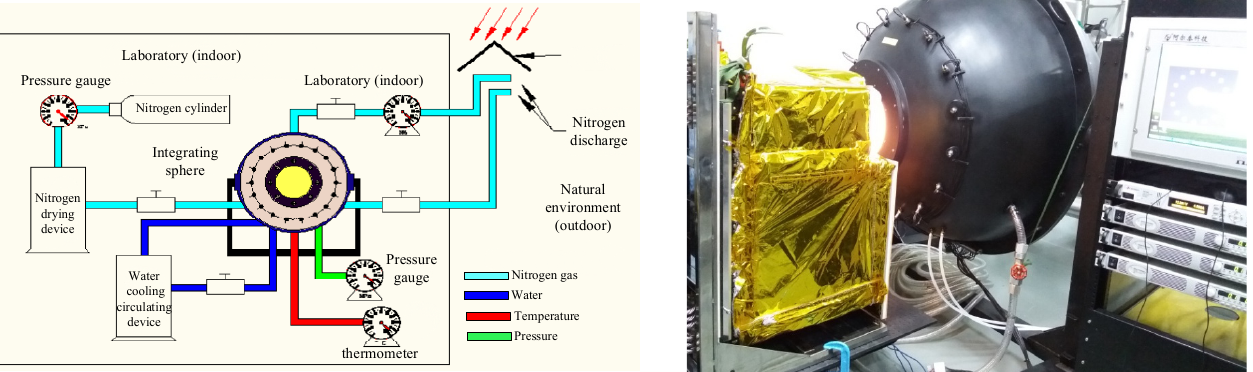
Figure 4. Schematic diagram of the nitrogen circulation standard integrating sphere radiation source ( left figure ) and the radiation calibration experiment ( right figure ).